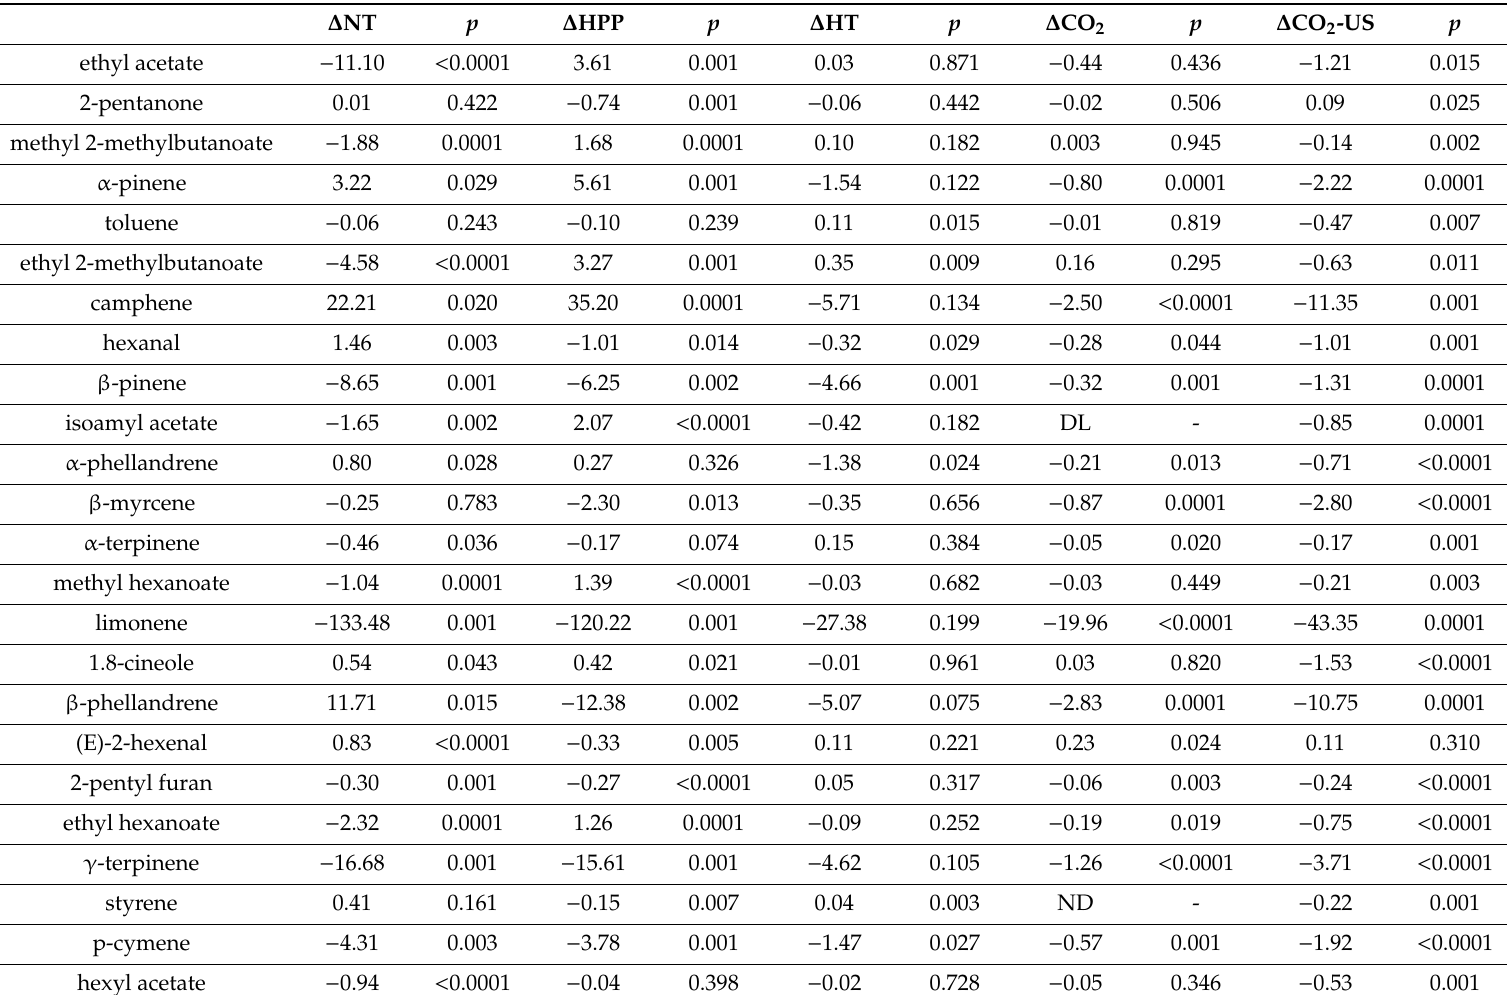
Table 5. Variation in concentration of volatile compounds between pomegranate juices at t 0 and t 28 ( ∆ *) and ANOVA p -values ( p